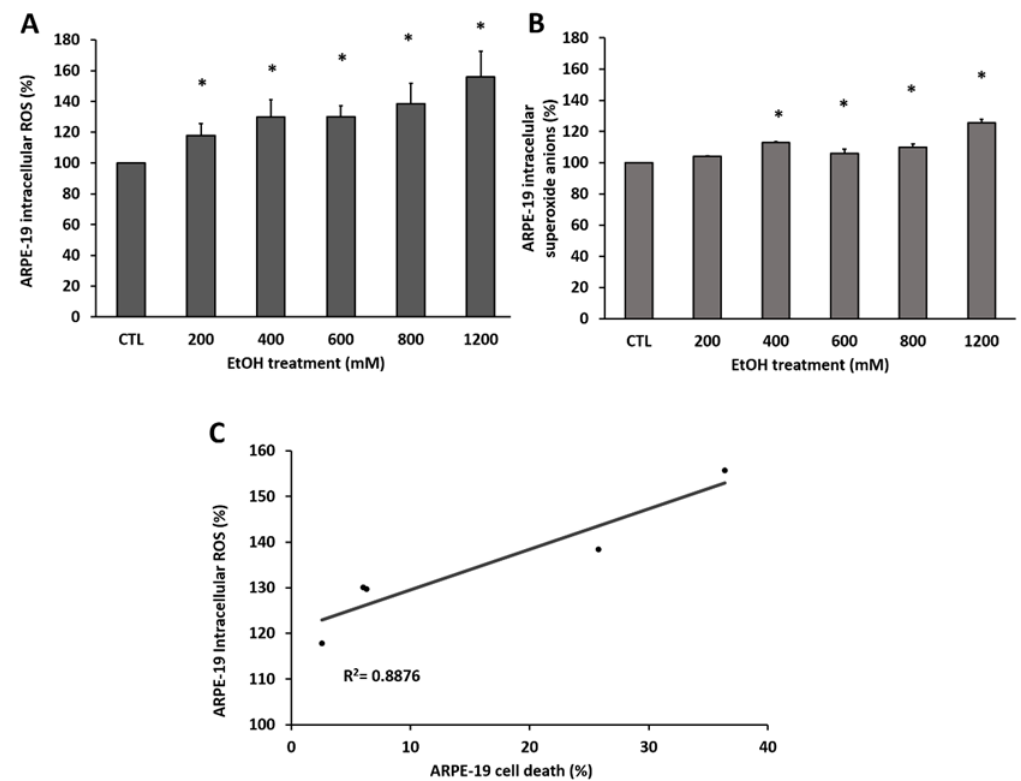
Figure 1. Intracellular reactive oxygen species (ROS) accumulation and cell death in ARPE-19 after ethanol (EtOH) exposure. ( A ) After 24 h of EtOH treatment with increasing concentrations, total intracellular ROS were measured by 2-7-dichlorodihydrofluorescein diacetate (DCFDA) fluorescence probe and ( B ) superoxide anions by DHE fluorescence probe. ( C ) Lineal correlation between total intracellular ROS and cell death measured by XTT. Values are expressed as mean ± SEM (N = 3–4). Statistically significant differences were set at * p < 0.05 vs. control (CTL) group.